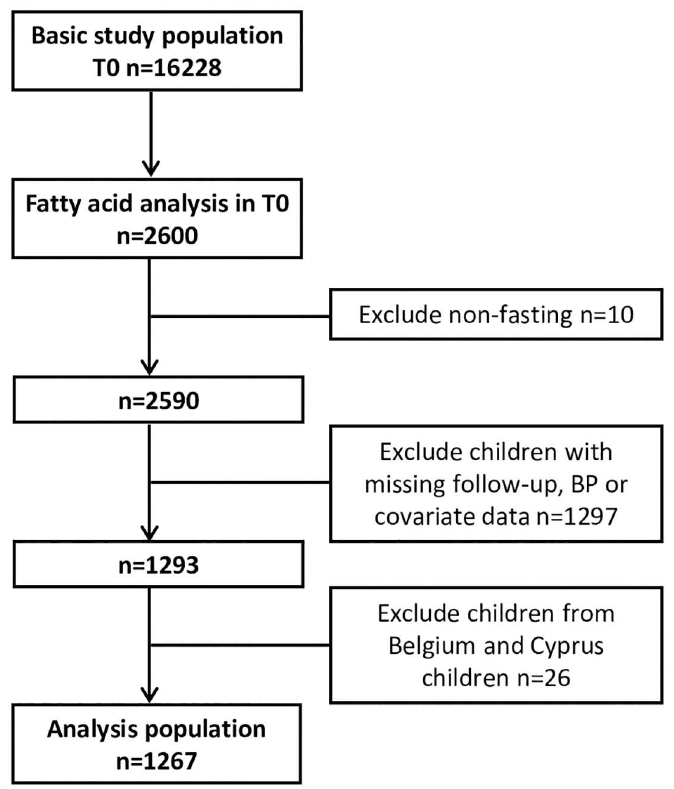
Fig 1. Flow chart of the inclusion and exclusion of IDEFICS/I.Family